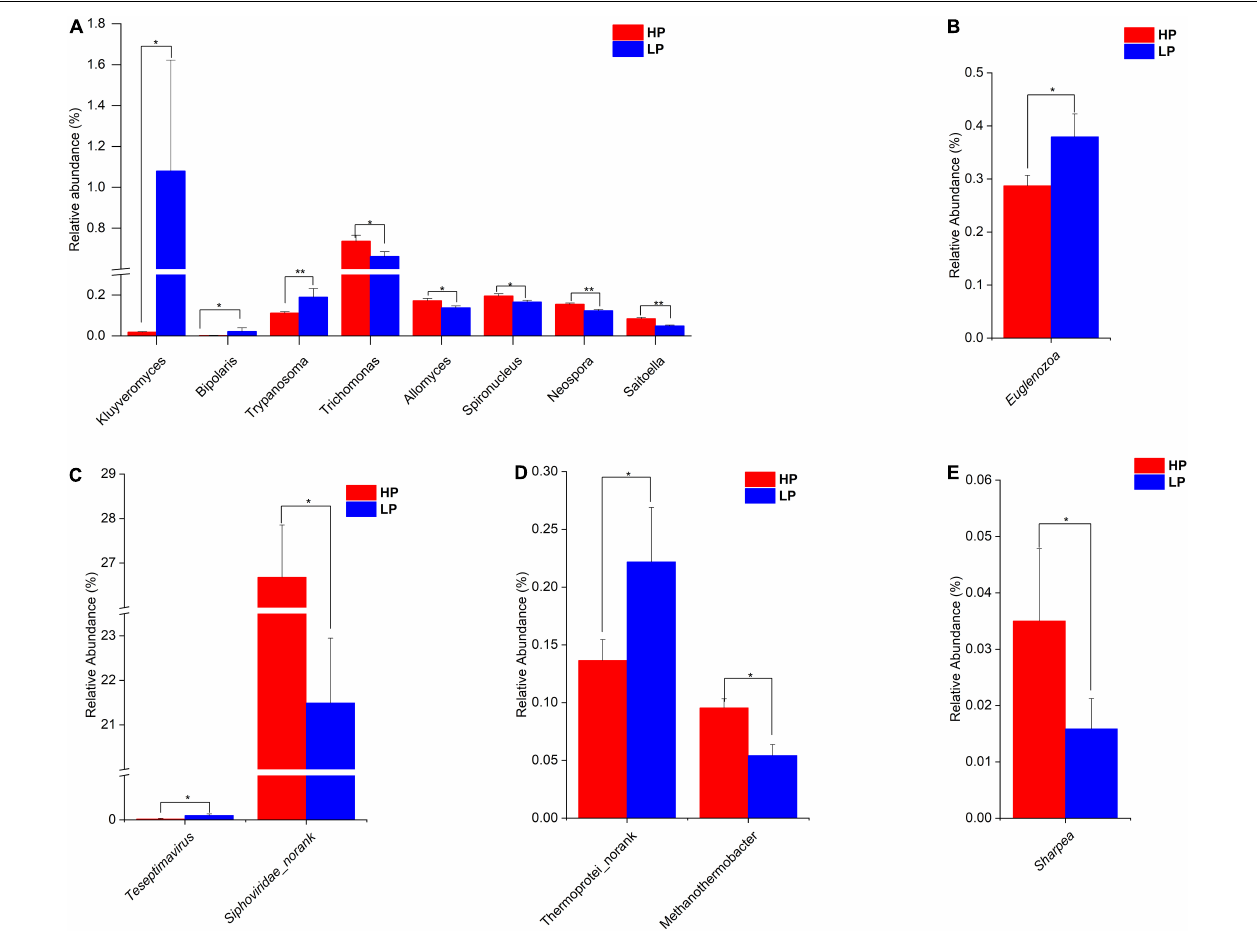
FIGURE 2 | (A) Relative abundance of differential Eukaryota genera ( P < 0.05, LDA > 2) in the HP and LP groups. (B) Relative abundance of differential Eukaryota phylum ( P < 0.05, LDA > 2) in the HP and LP groups. (C) Relative abundance of differential Virus genera ( P < 0.05, LDA > 2) in the HP and LP groups. (D) Relative abundance of differential Archaea genera ( P < 0.05, LDA > 2) in the HP and LP groups. (E) Relative abundance of differential Bacteria genus ( P < 0.05, LDA > 2) in the HP and LP groups. *indicates significant difference ( p < 0.05), **indicates significant difference ( p <